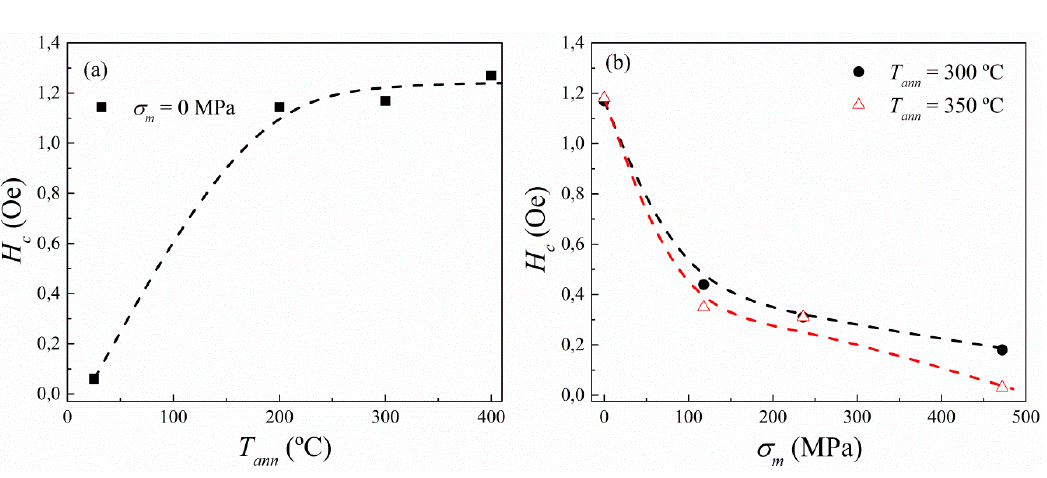
Figure 2. Temperature-annealing ( a ) and stress-annealing ( b ) dependence on the H c of Co 69.2 Fe 3.6 Ni 1 B 12.5 Si 11 Mo 1.5 C 1.2 microwires for 1 h of thermal-treatment. Dashed lines are a guide to the